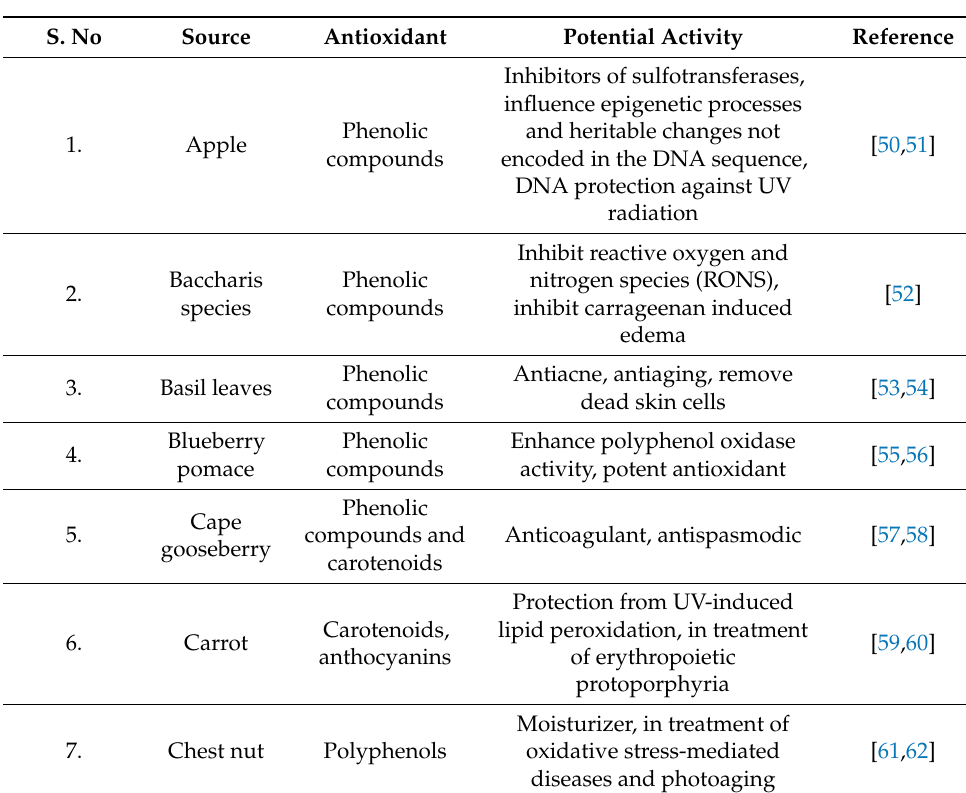
Figure 1. Driving factors of skin aging. Table 1. Natural